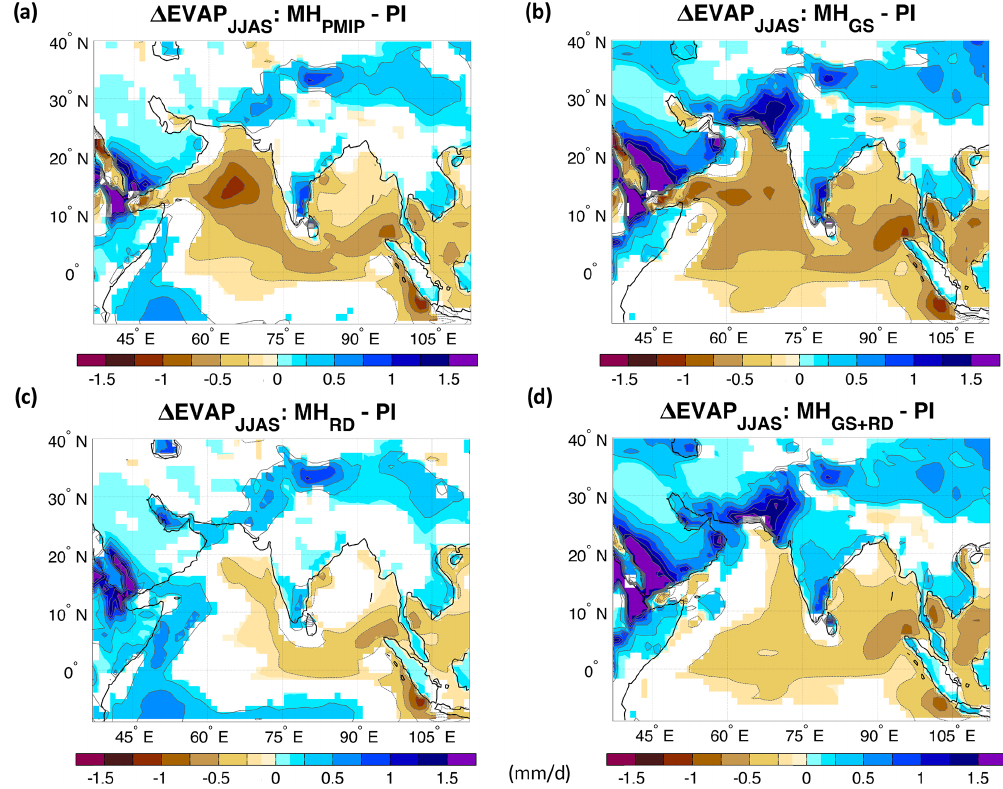
Figure 6. Changes in summer (JJAS) evapotranspiration (EVAP; mm/d) for the (a) mid-Holocene-only orbital forcing (MH PMIP ); (b) the Sahara greening (MH GS ); (c) the dust-only reduction (MH RD ); and (d) the Sahara greening and dust reduction (MH GS + RD ) experiments relative to the PI reference simulation. The contour lines follow the color-bar scale (the 0 lines are omitted for clarity). Only differences significant at the 95% confidence level using the Student t test are